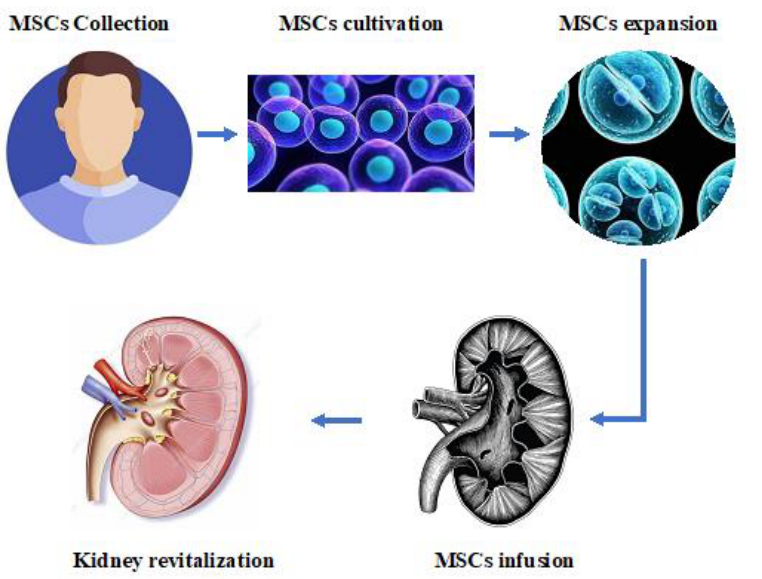
Figure 2. This figure depicts the experimental setting of renal revascularization using MSC infusion. The presence of MSCs in different tissues, where they show the ability to differentiate into resident mature cells, continues throughout life; however, it has been reported that the number and the functionality of these cells can be influenced by age [93]. In embryos, the differentiation status of totipotent zygotic cells stops at the stage of pluripotent embryonic cells, which constitute the germ layer. After this phase, stem cells will reside in specific areas of several tissues, where they can move from quiescence to activation at any moment. They can respond to specific triggers with differentiation to mature cells with consequent tissue regeneration. This typically occurs in the concomitance of renal inflammation and fibroblast activation [94,95]. On the other hand, it has been reported that MSCs collected from patients with ARVD might exhibit impaired function, senescence, and DNA damage, possibly determined via epigenetic